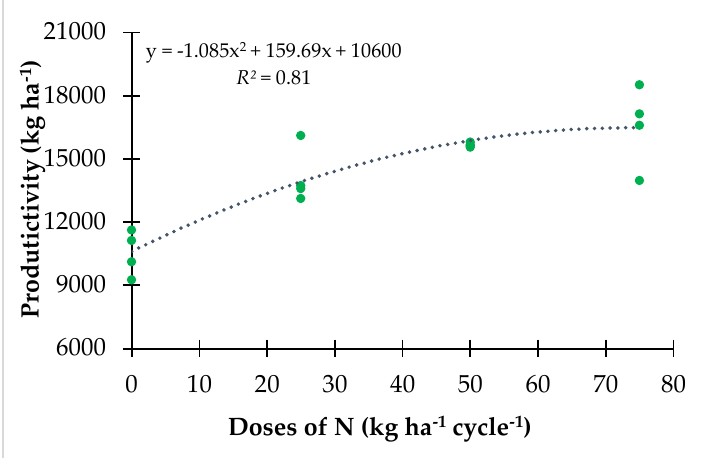
Figure 3. Biomass productivity (“leaf” and “sheath + thatch” biomass components) of Mombasa cultivar with different doses of N.